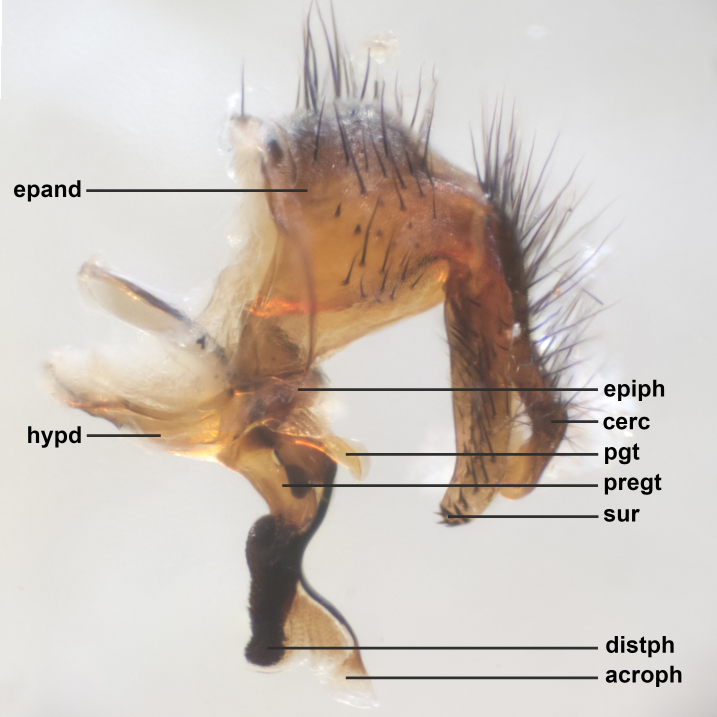
Detailed lateral view of male genitalia of Hyphantrophaga
nigricauda
sp. n. Abbreviations: acroph = acrophallus; cerc = cercus; distph = distiphallus; epand = epandrium; epiph = epiphallus; hypd = hypandrium; pgt = postgonite; pregt = pregonite; sur = surstylus